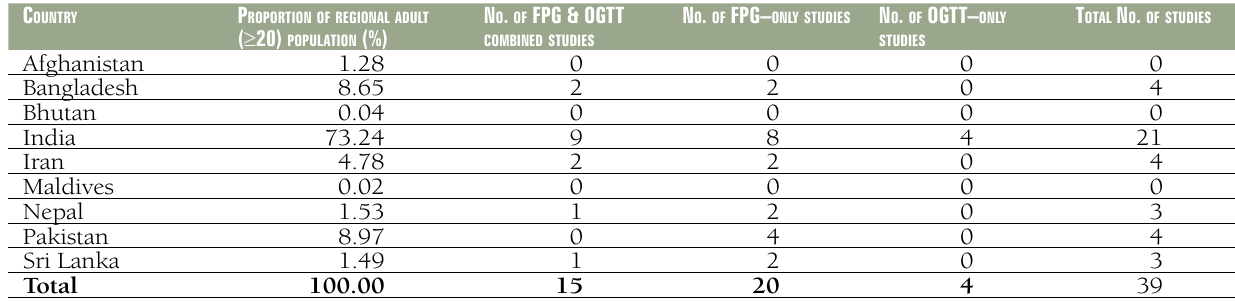
Table 5. Study characteristics by country